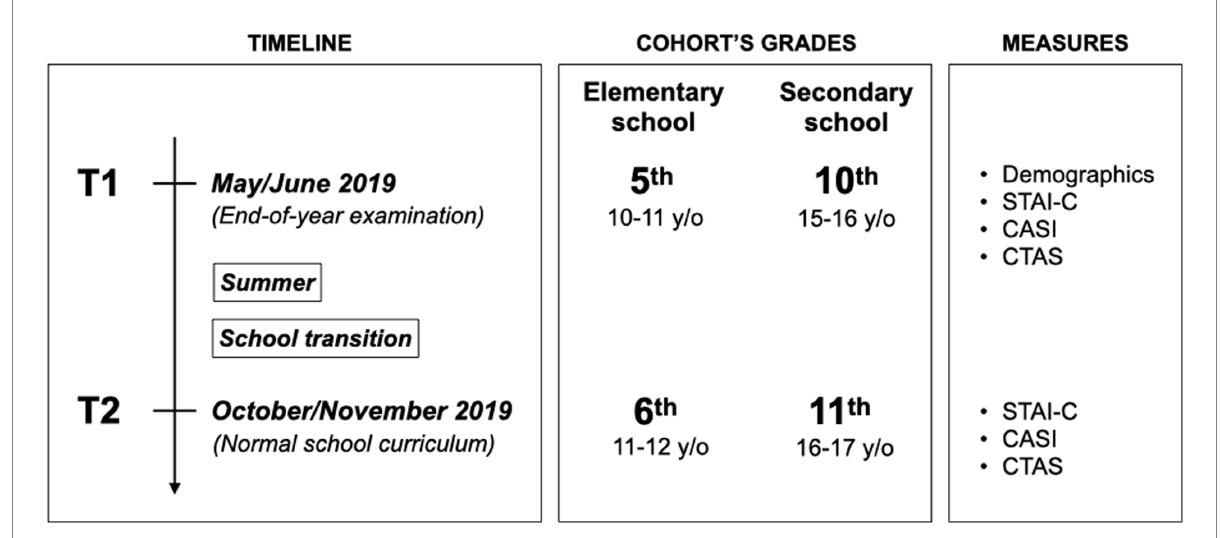
FIGURE 1 Schematic representation of the study design and testing periods. STAI-C = State-Trait Anxiety Inventory for Children, CASI = Childhood Anxiety Sensitivity Index, CTAS = Children’s Test Anxiety Scale.